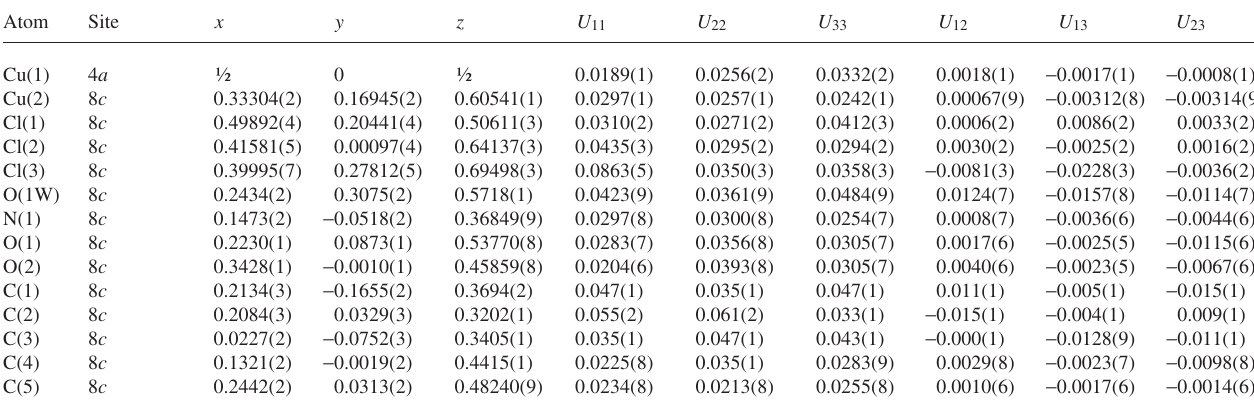
Table 3. Atomic coordinates and displacement parameters (in Å 2 ) .